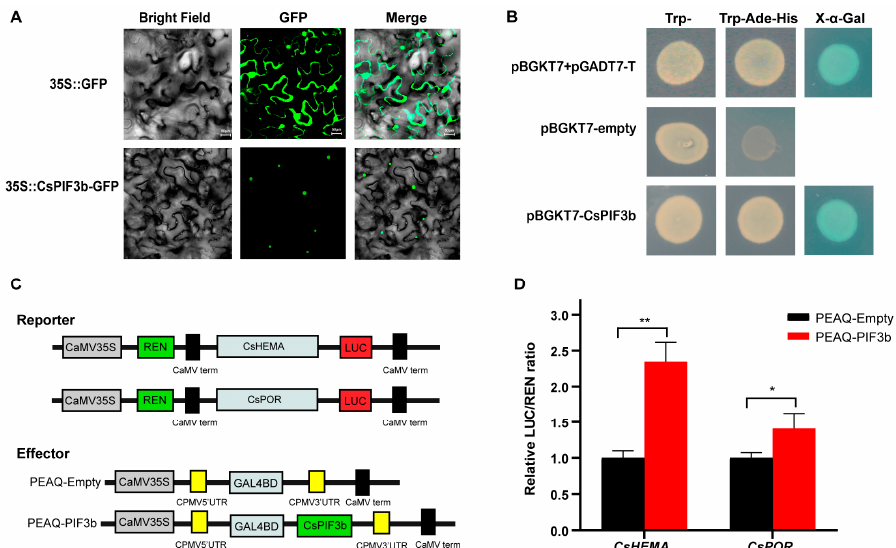
Figure 6. Molecular Characteristics of CsPIF3b protein. ( A ) Subcellular localization of CsPIF3b in N. benthamiana leaves. Images with GFP signals were taken using fluorescent microscope. Bars, 50 µ m. ( B ) Transcriptional activation activity of CsPIF3b in yeast cells. The transcriptional activation ability of CsPIF3b were evaluated based on growth and X- α -Gal activity of yeast on SD plates (SD/-Trp/-His/-Ade). ( C ) Diagrams of the reporter and effector constructs used in dual-luciferase transient expression system. ( D ) Trans-activation of CsPIF3b to promoter of chlorophyll-related genes by CsPIF3b in N. benthamiana leaves. The trans-activation of CsPIF3b to CsHEMA and CsPOR were determined by the LUC/REN ratio. Bar graphs are expressed as mean ± SEM, * P < 0.05; ** P < 0.01 vs. the PEAQ-Empty group.